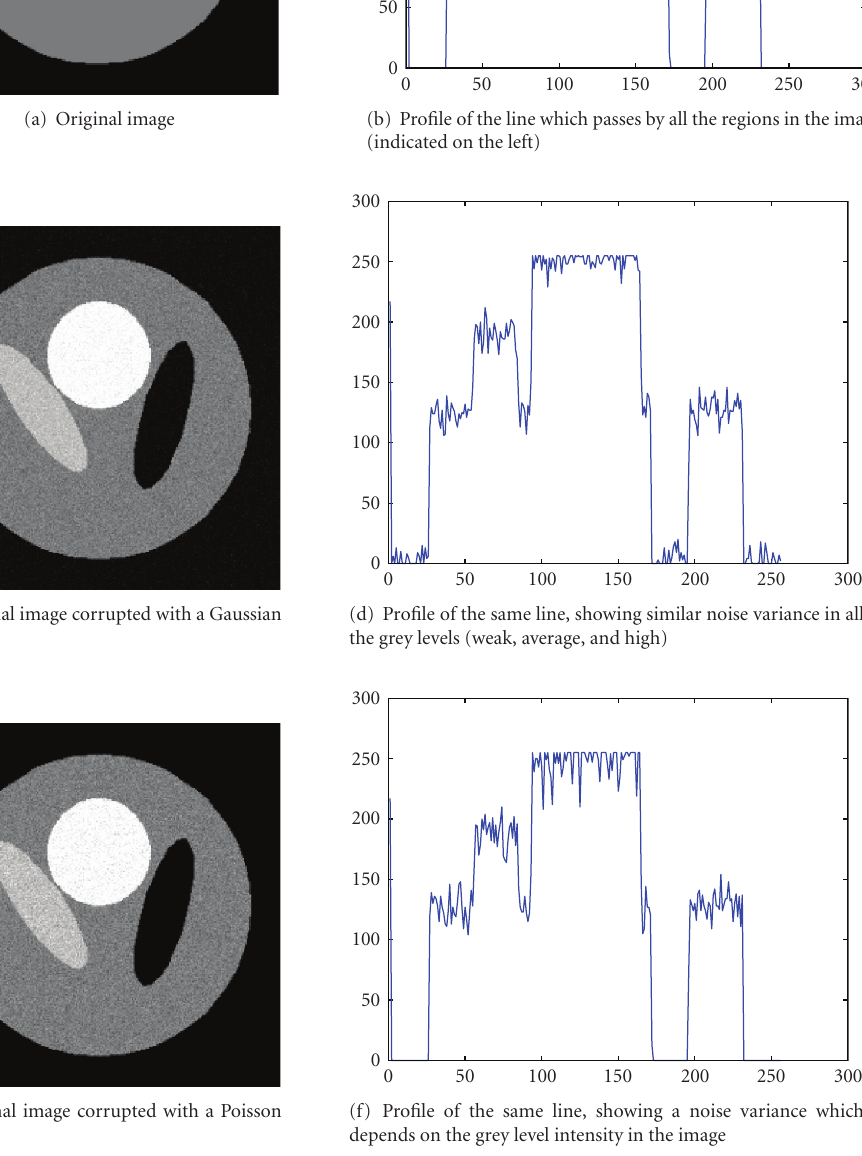
Figure 1: Illustration of the di ff erence between a Gaussian and a Poisson